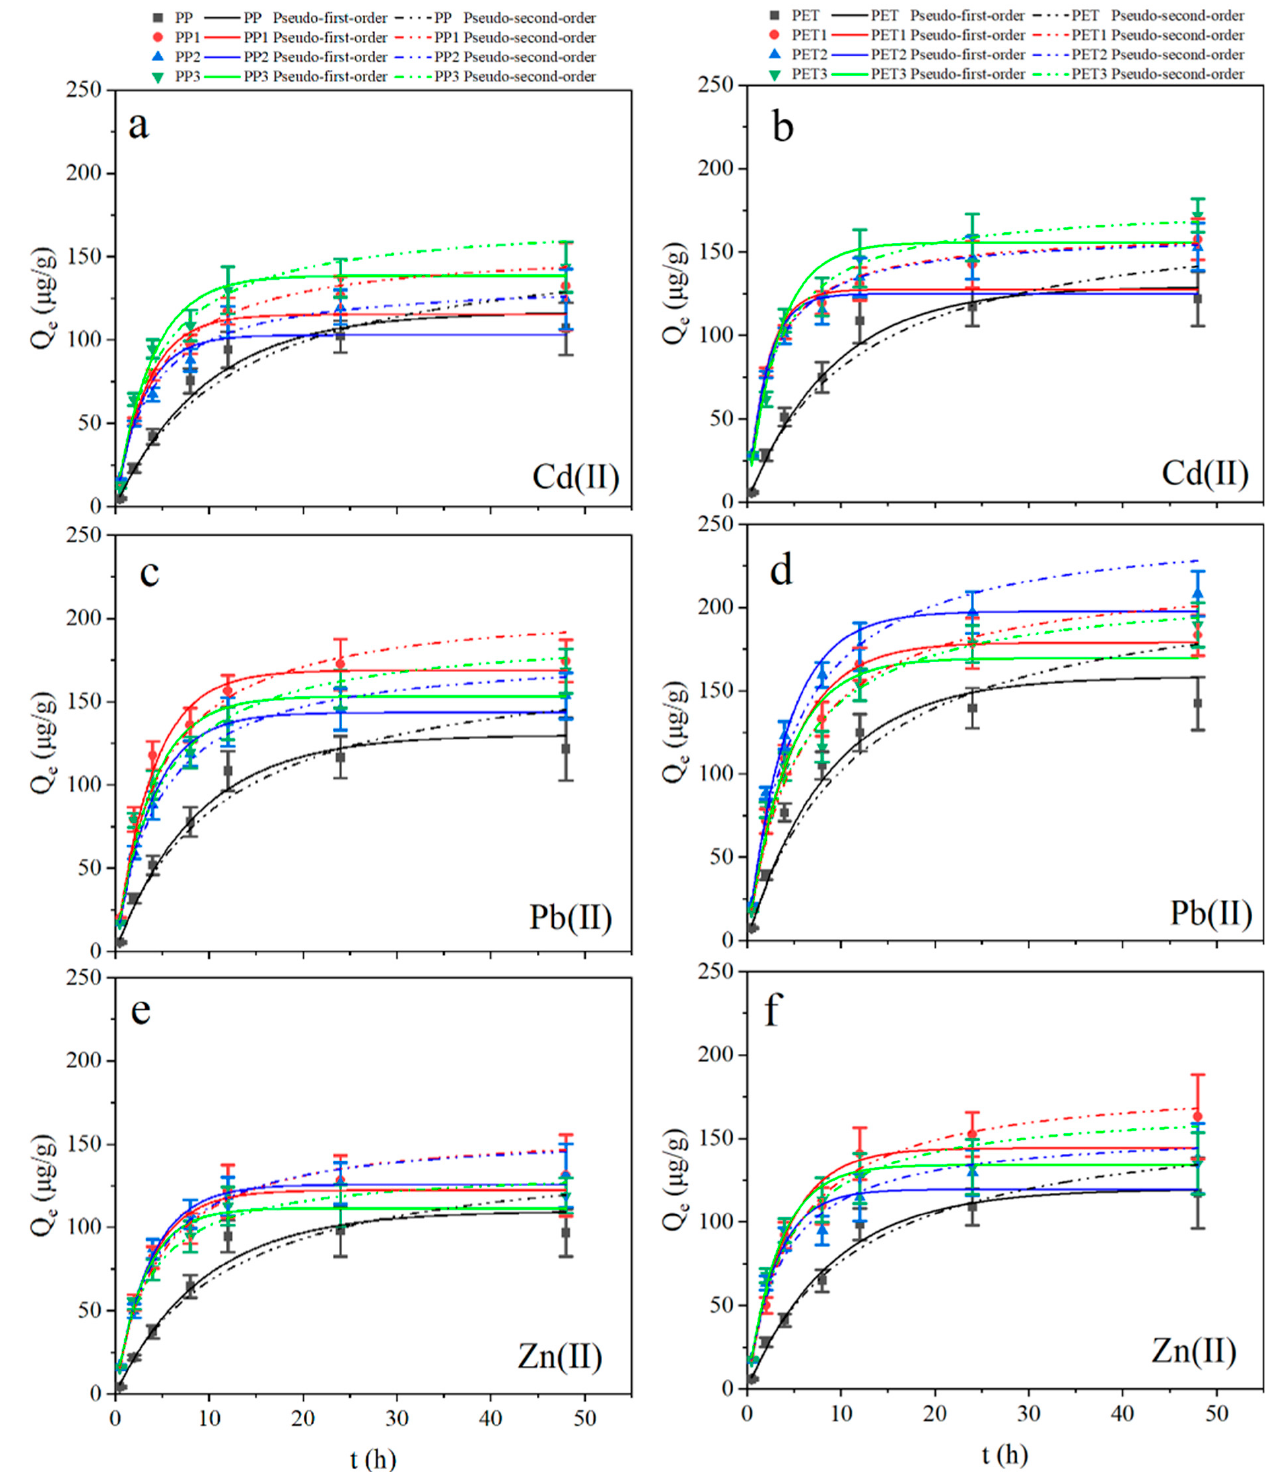
Figure 5. Adsorption kinetics of Cd(II) ( a , b ), Pb(II) ( c , d ) and Zn(II) ( e , f ) for plastic debris. PP and PET: virgin plastic; PP1 and PET1: biofilm-covered plastic in Xuanwu Lake; PP2 and PET2: biofilm-covered plastic in Donghu Lake; PP3 and PET3: biofilm-covered plastic in the Qinhuai River.